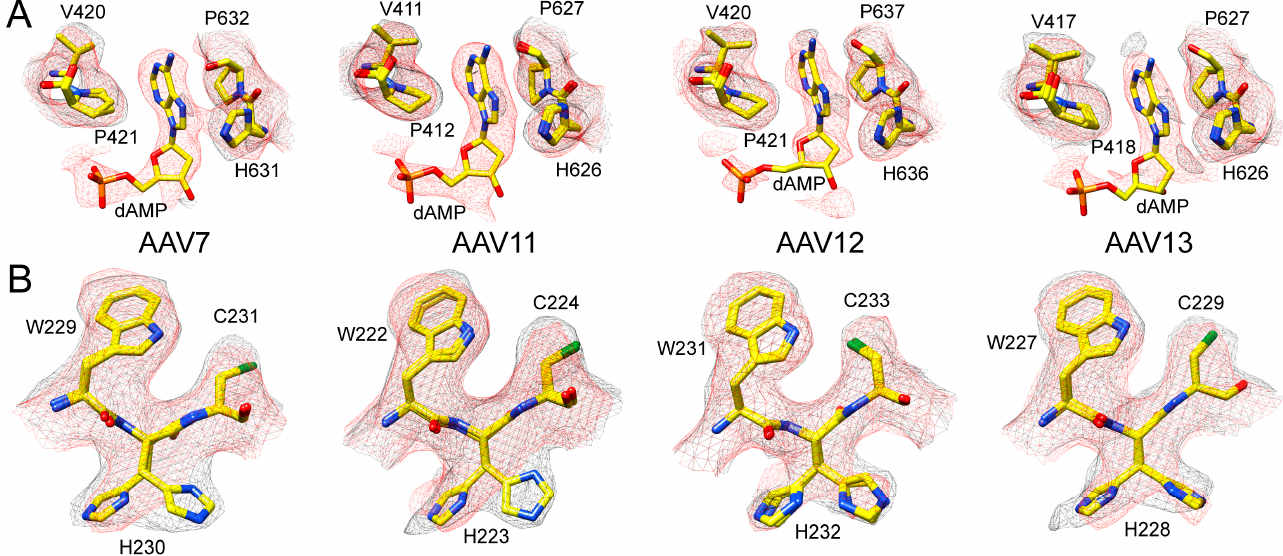
Figure 3. Empty and full Adeno-associated virus (AAV) density map differences. ( A ) The modeled AAV7 and AAV11–13 residues at the nucleotide binding pocket with their respective mesh density maps (black = empty, red = full). The extra density exclusively in the full maps was interpreted as an ordered nucleotide (deoxyadenosine monophosphate, dAMP). ( B ) Dual conformation of histidines (e.g., H230 in AAV7). This histidine adopts alternative side-chain conformations primarily in the absence of packaged DNA with the exception of AAV12. Atom colors: C = yellow, O = red, N = blue, S = green, P = orange. This figure was generated using UCSF-Chimera [48].